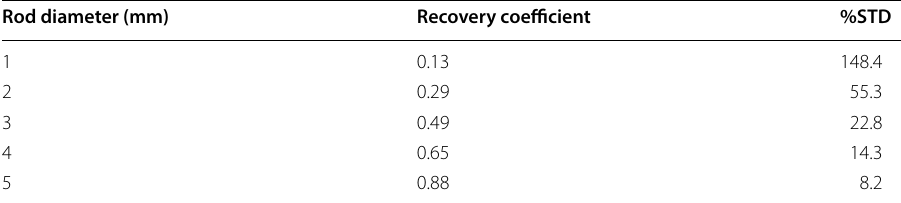
Table 8 Recovery coefficients for the hot rods in the NEMA image quality phantom Rod diameter (mm) Recovery